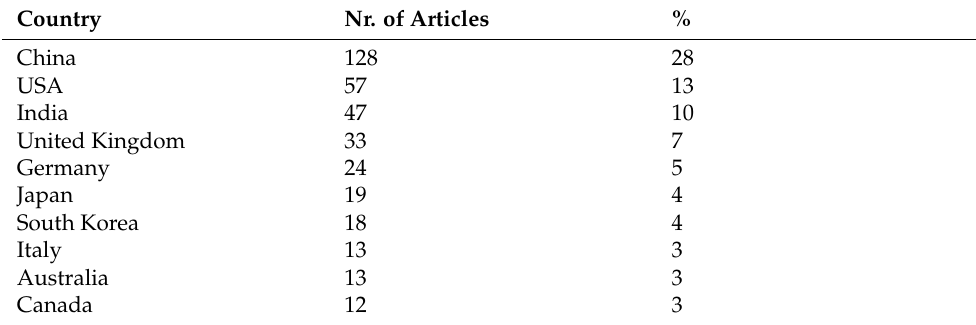
Table 9. Top 10 countries regarding the contribution to the